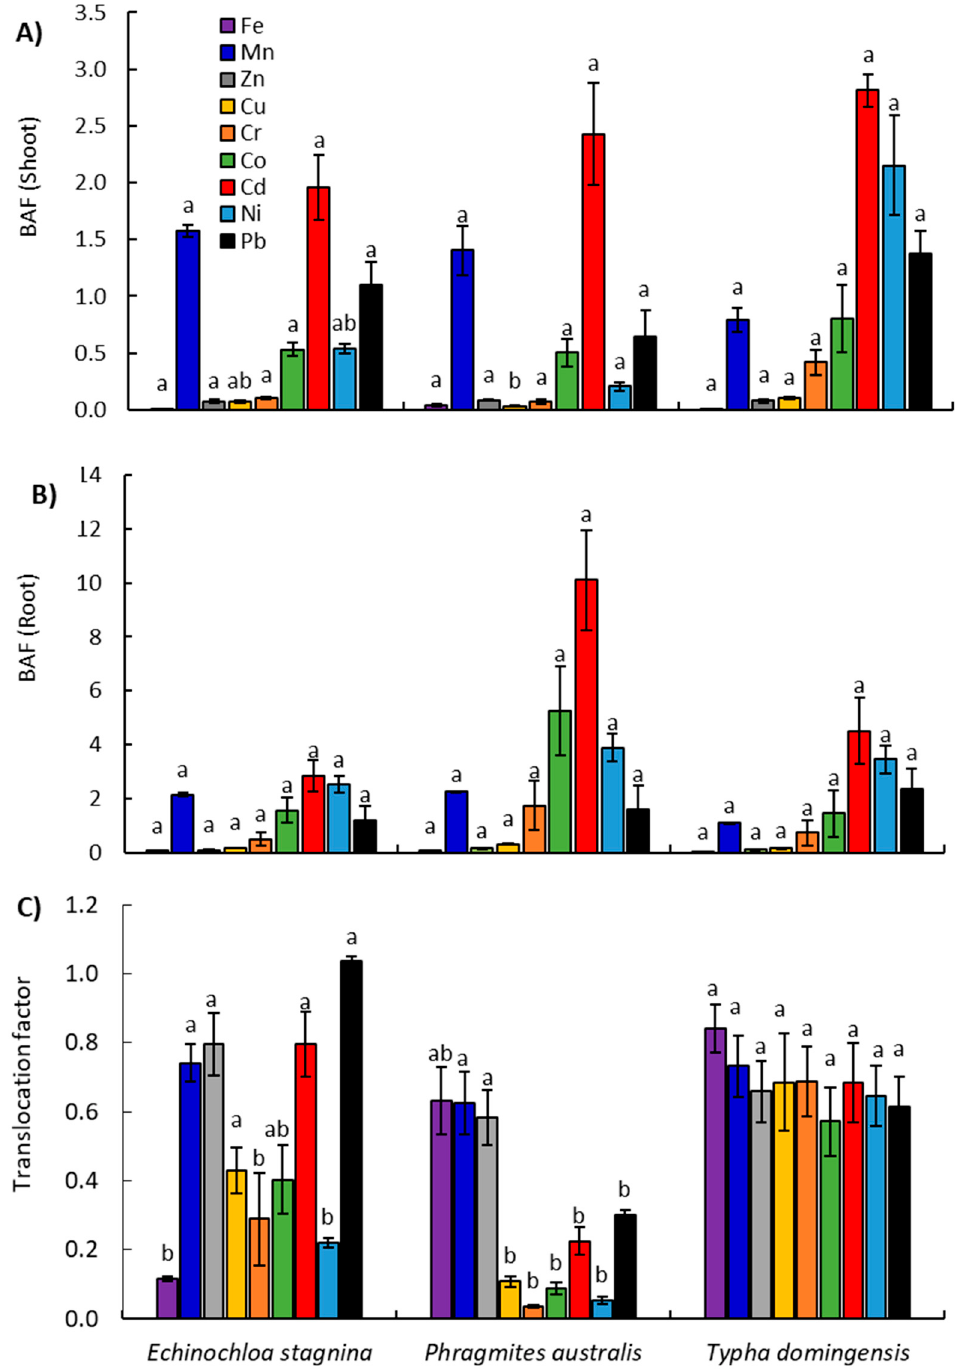
Figure 4. Bioaccumulation factor (BAF) of heavy metals in the shoots ( A ) and root ( B ), and the translocation factor ( C ) of the three studied emergent hydrophytes naturally growing along the studied drains. Di ff erent letters per each metal mean significant di ff erences at values of p ≤ 0.05. The heavy metal distribution between the belowground and aboveground organs of P. australis , E. stagnina and T. domingensis was represented by the value of translocation factors (TF) (Figure 4C). According to the TF data, the highest values of Fe, Cu, Cr, Co and Ni (0.84, 0.69, 0.69, 0.57 and 0.65, respectively) were observed in T. domingensis , while those of Mn, Cd, Pb and Zn (0.74, 0.79, 0.80, and 1.04, respectively) were found in E. stagnina (Figure 4C and Table S4). In the present study,